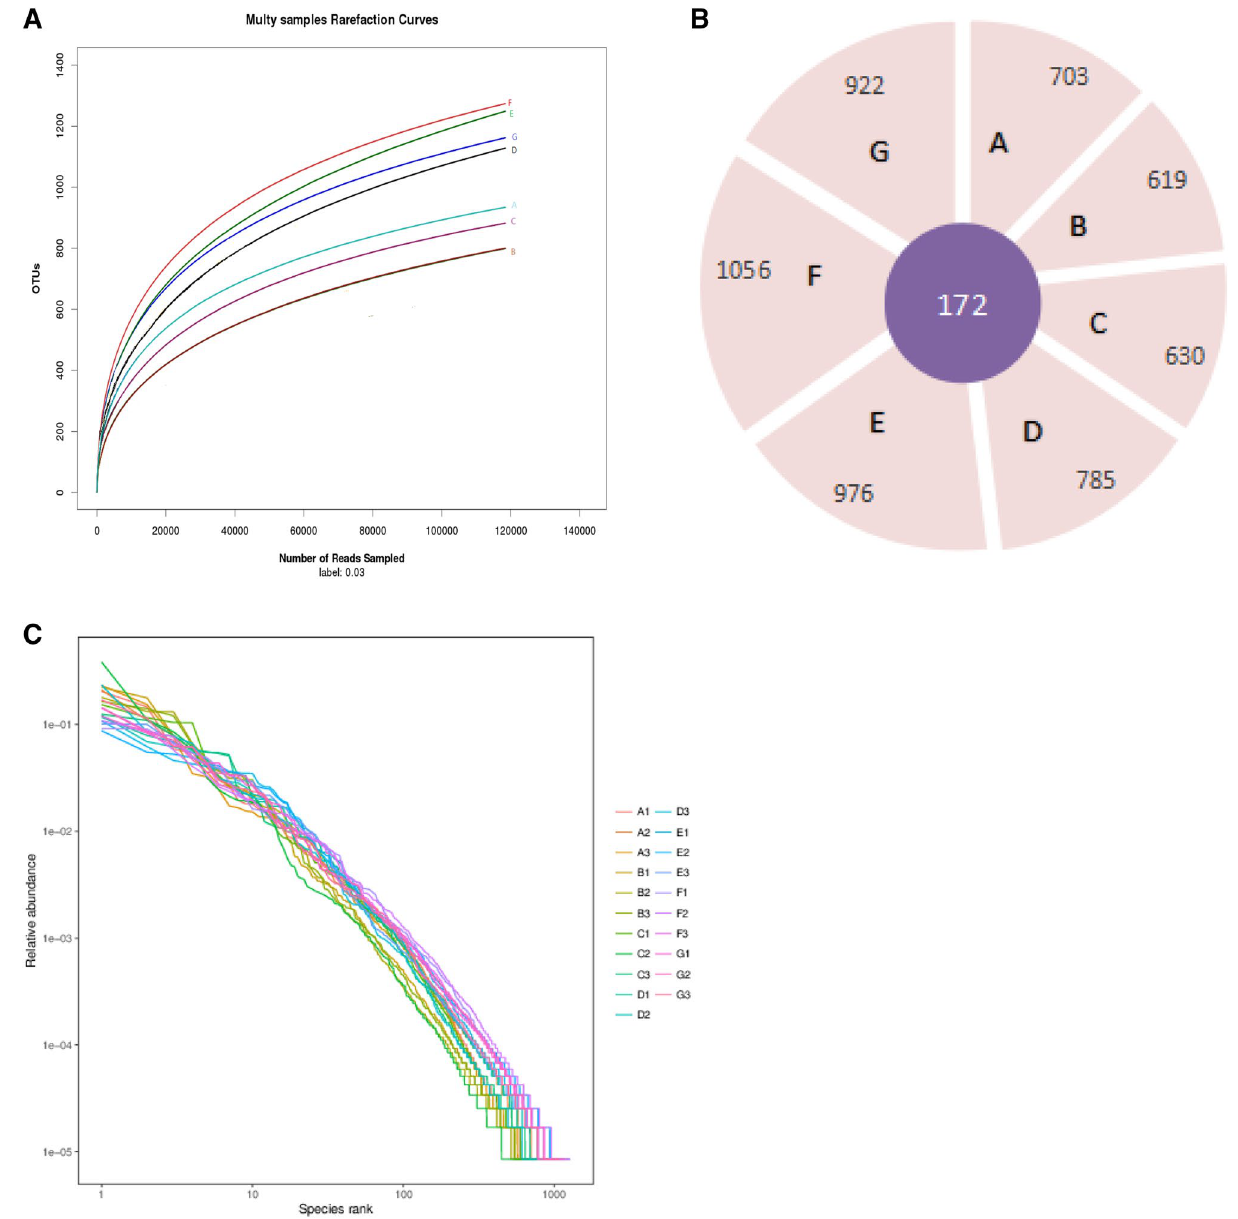
Figure 2. ( A ) Rarefaction curves of OTUs clustered at < 97% sequence identity for 21 different rhizoshpere soil samples of corn seed production from 5, 10, 15, 20, 25, 30 and 30 years of continuous cropping. Uppercase of A, B, C, D, E, F and G represent 5, 10, 15, 20, 25, 30, and 30 years, respectively. The subscript below the letter represent three duplicates of the same cropping year. The OTUs reads of different samples are shown in different colors. ( B ) Flower graph of OTUs of different continuous cropping year. Uppercase A, B, C, D, E, F, and G represent 5, 10, 15, 20, 25, 30, 30 years, respectively. The core was the common OTUs for different treatment. ( C ) OTUs relative abundance curves for the OTUs in the 21 different corn seed production rhizoshpere soil samples from 5, 10,15, 20, 25, 30 and 30 (with field corn) years of continuous cropping. Uppercase A, B, C, D, E, F, and G represent 5, 10, 15, 20, 25, 30, and 30 years, respectively. The subscript below the letter represent three duplicates of the same cropping year. The OTUs reads of different samples are shown in different